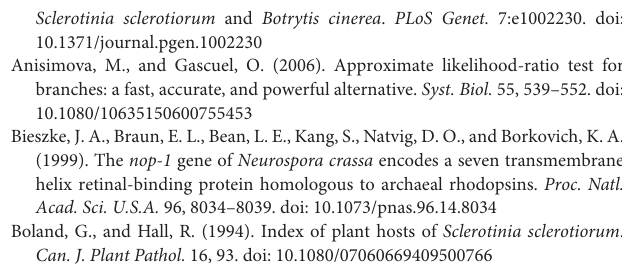
Figure S1 | Sop1 silenced transformants showing significantly reduced virulence on detached tomato leaves. Virulence of the sop1 silenced transformants and the wild-type strain was evaluated according to the lesion diameter at 20 ◦ C for 48h. Three independent replications were performed. The values are presented as the mean ± s.d. Differentiation was evaluated by a t -test. Different letters on the graph indicate statistical significance, P = 0 .05. Figure S2 | Biological characterization of the sop1 silenced transformants obtained by the other gene silencing strategy. (A) The construction of sop1 silencing vector pRNAi-2. (B) Phenotypes of the sop1 silenced transformants and the wild-type strain grown on PDA at 20 ◦ C. Photos were taken at 8 dpi. (C) Comparison of the virulence of the silenced transformants and the wild-type strain on detached oilseed rape leaves at 20 ◦ C for 48h. (D) Relative sop1 expression level of the sop1 silenced transformants and the wild-type strain as determined by qRT-PCR analysis. A value of 1 was assigned to the abundance of cDNA from the wild-type strain. The sop1 expression levels in the silenced transformants and the wild-type strain were normalized to that of the β -tubulin transcripts from each strain. (E) Comparison of lesion diameter of the silenced transformants and the wild-type strain. (F) Comparison of the hyphal growth rate of the silenced transformants and the wild-type strain. Three independent replications were performed. Bars indicate the standard error. The values are presented as the mean ± s.d. Differentiation was evaluated by a t -test. Different letters on a graph indicate statistical significance, P = 0 .05. Table S1 | Differentially expressed signaling genes identified by the DGE during different developmental stages of S. sclerotiorum compared with the vegetative growth stage. Red and green indicate significantly up-regulated and down-regulated gene expression, respectively. Blank cells without numbers indicate genes that were not detected in the DGE data or not differentially expressed during corresponding developmental